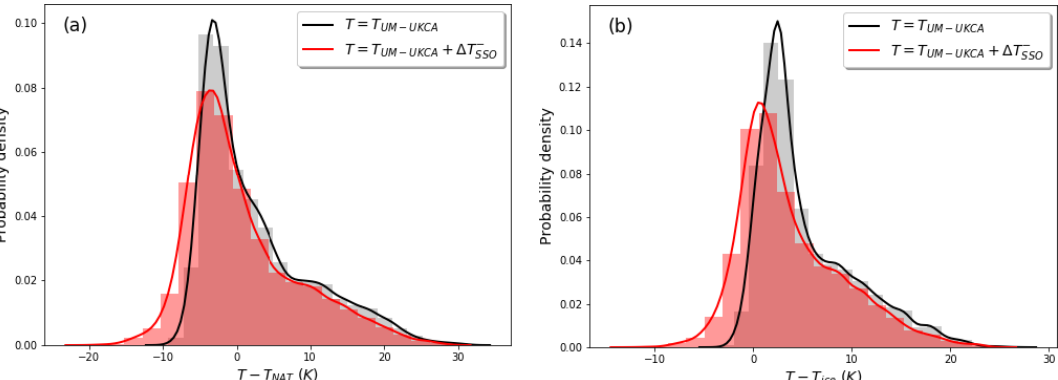
Figure 5. Comparison of the probability distributions of the temperature differences (K) for (a) T − T NAT and (b) T − T ice over the Antarctic Peninsula at an altitude of 20.4km for the combined months of May to October for the perturbation run (red line) and the control run (black line), i.e. for T equal to either T UM − UKCA + (cid:49)T − (perturbation run with the parameterisation scheme on) or T UM − UKCA (control run SSO with the parameterisation scheme off). Note that the results are computed within the box indicated in Fig. 1.